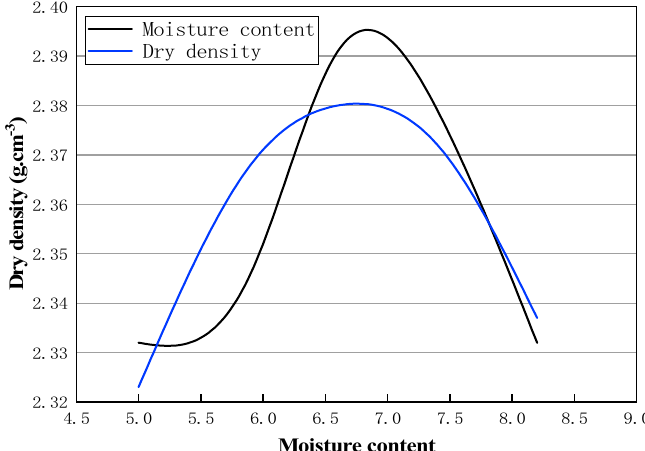
Figure 4. Curve of the moisture content and dry density.